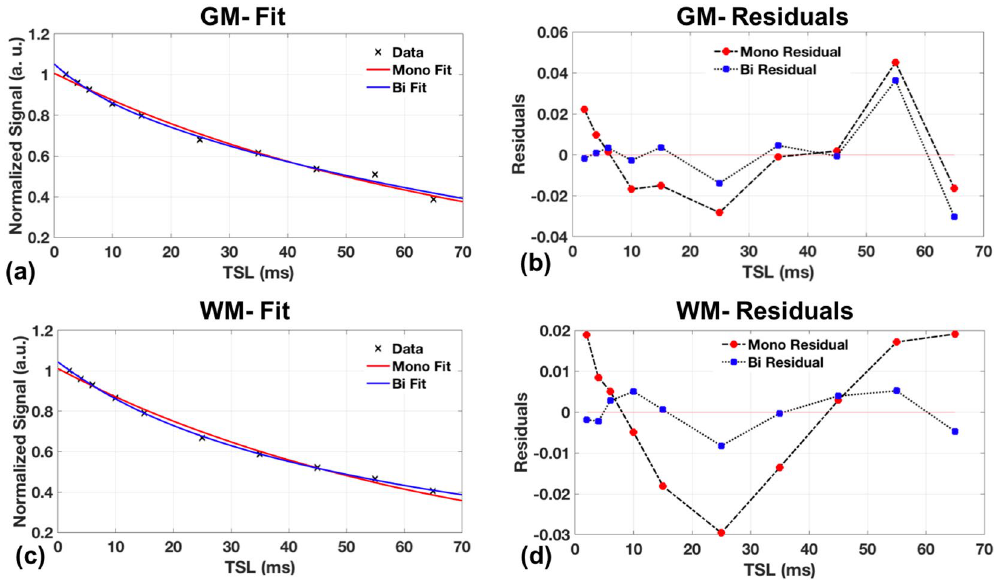
Figure 4. Signal decays from representative voxels with mono- and bi-exponential fits in the gray-matter of the brain ( a ), and the white matter of the brain ( c ) with the corresponding residuals ( b , d ). The WM fits and residuals clearly indicate bi-exponentials as a better fit to the data, compared to the